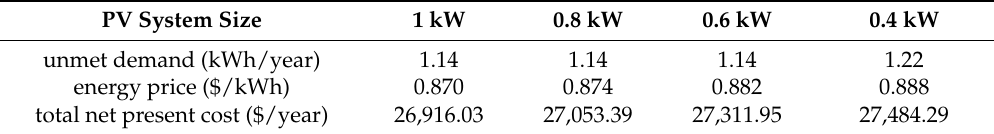
Table 4. Summary of the system under different sizes of photovoltaics.